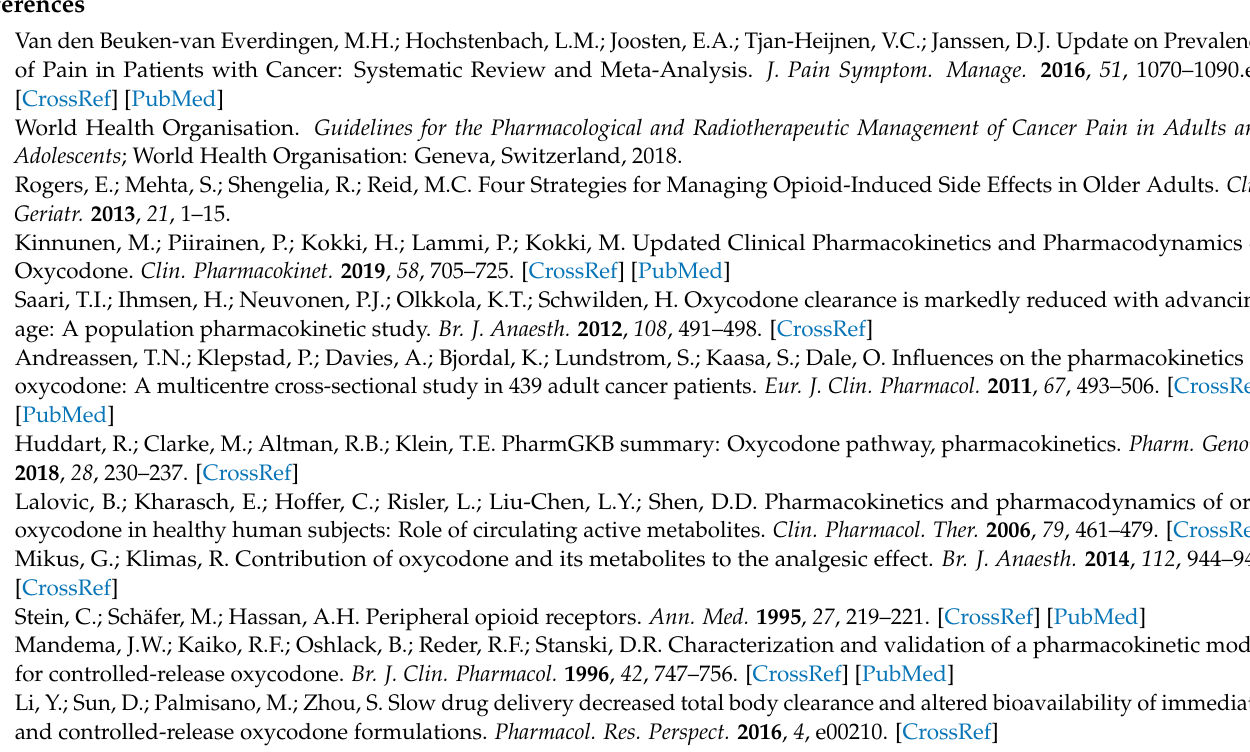
nor-oxymorphone, Figure S4: Normalized Prediction Distribution Error plots, Table S1: CYP3A4 and CYP2D6 inducers and inhibitors, Document S1: Covariate equations, Document S2: Control stream of the final